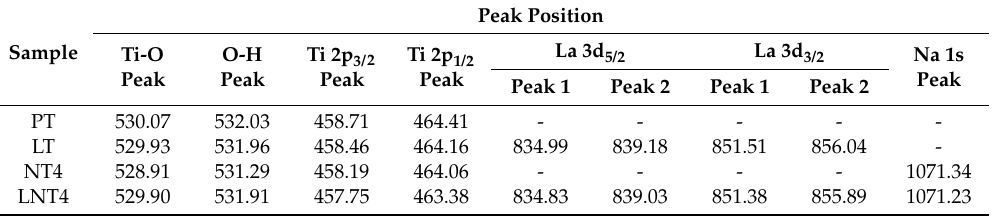
Table 3. Peak position of different peaks obtained from high resolution XPS of different samples.